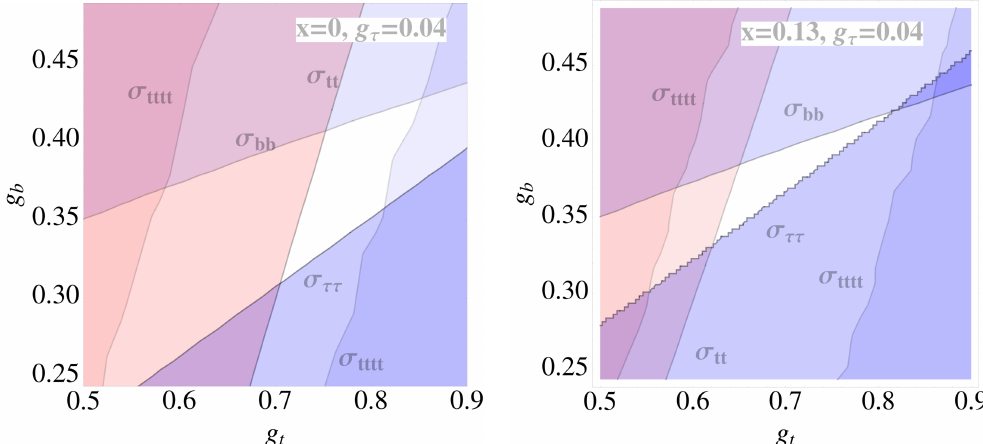
Figure 1 . Production cross-section predictions of relevant 400-GeV pseudoscalar channels with 1 σ uncertainties of in the [ g , g ] plane, with x = 0 (left panel) and x = 0.13 (right panel). In t b both plots g is fixed to 0.04. Each contour line is labeled with the 1 σ cross-section value of the τ corresponding considered channel. Blue and red shaded areas are excluded by